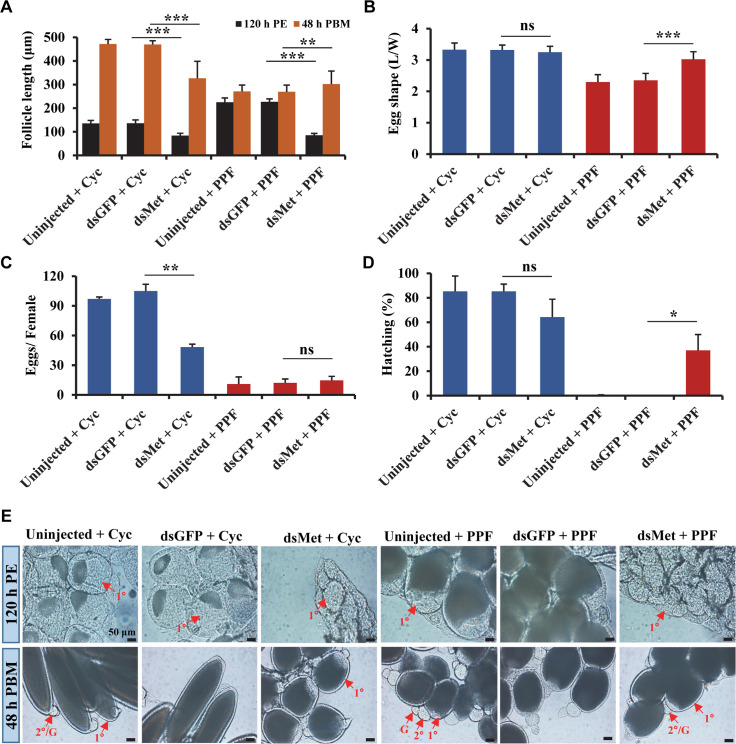
Implication of Met in the impaired egg maturation in the PPF-treated female mosquitoes.Adult female mosquitoes were injected with dsRNAs within 1 h after eclosion. The injected and uninjected mosquitoes were treated with cyclohexane (Cyc) or PPF at 72 h PE. All the mosquitoes were given a blood meal at 120 h PE. (A) Length of primary follicles. Follicular lengths (N = 30 follicles) were measures at 120 h PE and 48 h PBM. (B) Egg shape parameter (egg L/W ratio) was calculated after measuring the lengths and widths of 30 eggs. (C) Average number of eggs produced by each female mosquito. Oviposited eggs were counted at 6 days PBM. Data are shown as the mean ± standard deviation of three biological replicates (10 mosquitoes/replicate). (D) Hatching rates for different treatment groups. Eggs were allowed to hatch for 7 days to record the hatching rate. Error bars illustrate the standard deviation of three biological replicates (10 mosquitoes/replicate). Statistical analysis was conducted using paired t-test (ns, p > 0.05; *, p < 0.05; **, p < 0.01; ***, p < 0.001). (E) Ovarian follicular development. Follicles were dissected at 120 h PE and 48 h PBM. Differential Interference Contrast (DIC) images were taken using Zeiss Axiocam ERc5. PE: Post eclosion, PBM: Post blood-meal, 1°: primary follicle, 2°: secondary follicle, G: germarium.